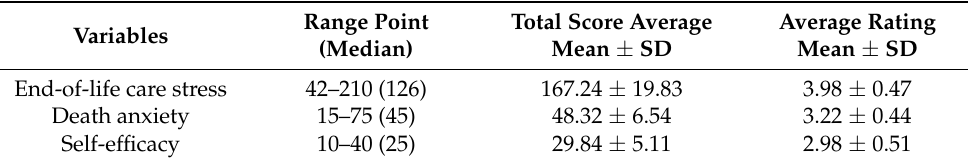
Table 2. Levels of terminal care stress, anxiety about death, and